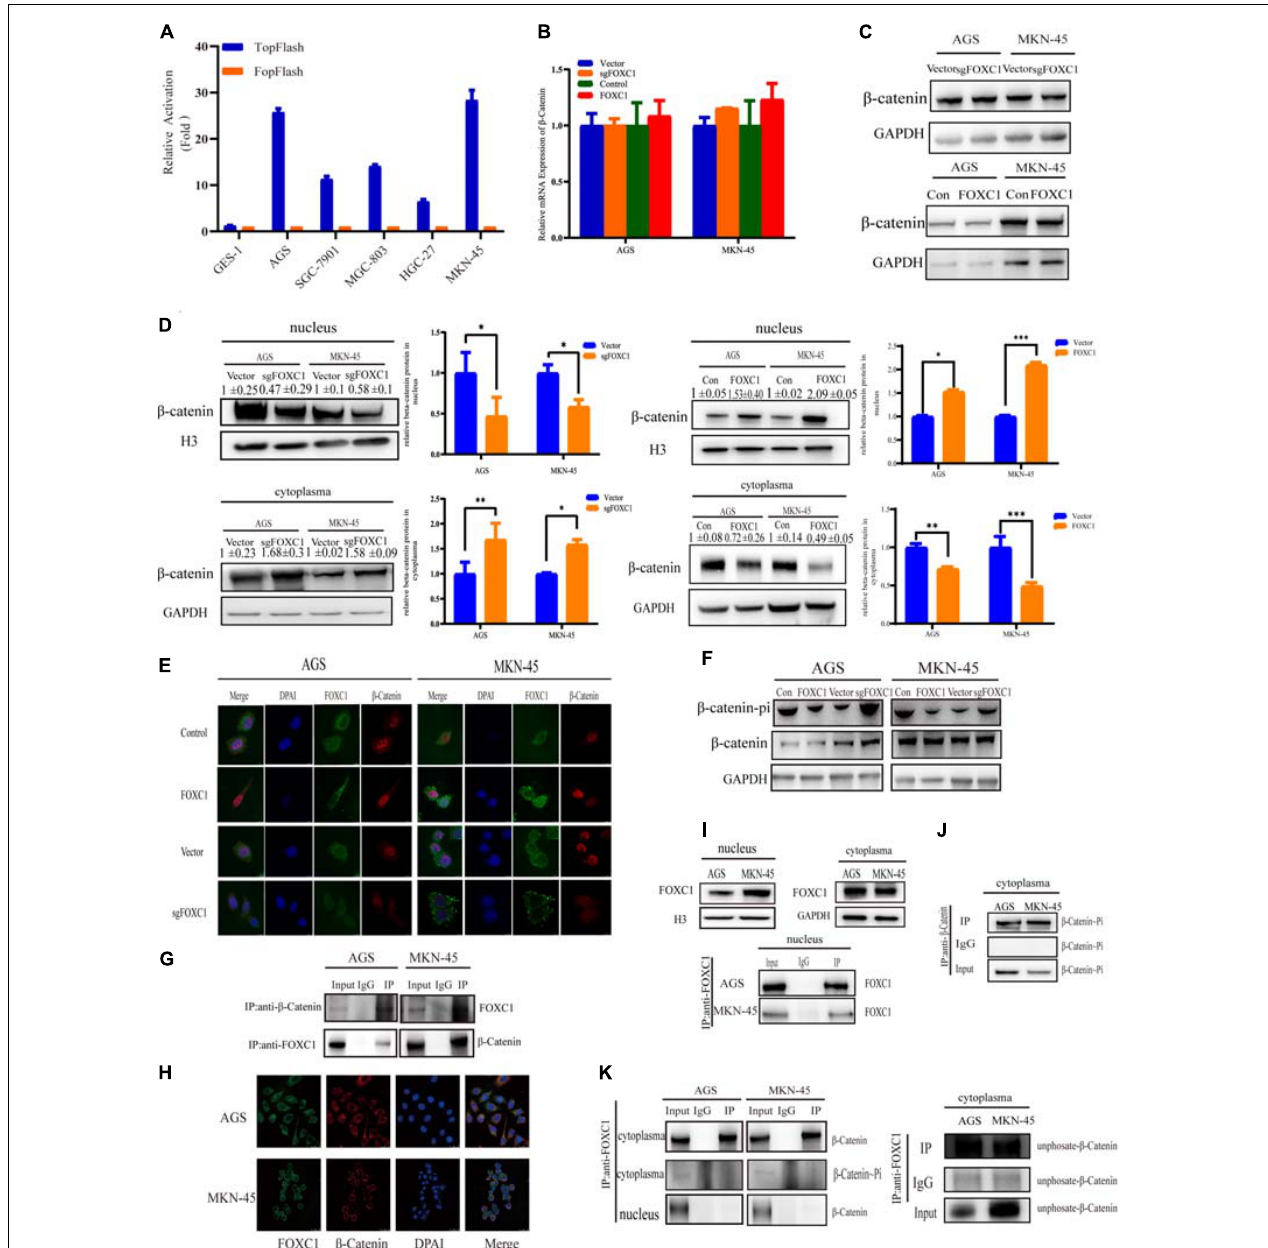
FIGURE 5 | FOXC1 enhances c-MYC expression to promote gastric cancer cell proliferation through activation of the Wnt signaling pathway. (A) TopFlash/FopFlash assays using normal gastric cells (GES-1) and gastric cancer cells (AGS, SGC-7901, MGC-803, MKN-45, HGC-27). (B) qPCR results in FOXC1 KO and FOXC1-overexpressing AGS and MKN-45 cells indicated that mRNA levels of β -catenin remained unchanged. (C) The results of western blot assays in FOXC1 KO and FOXC1-overexpressing AGS and MKN-45 cells indicated that protein levels of β -catenin remained unchanged ( β -catenin Antibody: CST #8480S). (D) FOXC1 KO increased β -catenin levels in the cytoplasm but decreased them in the nucleus ( β -catenin Antibody: CST #8480S). (E) Immunofluorescence assay in FOXC1 KO and FOXC1-overexpressing AGS and MKN-45 cells showed that the level of β -catenin translocation into nucleus changed with knockout and overexpression FOXC1 ( β -catenin Antibody: CST #8480S). (F) FOXC1 overexpression inhibit the phospho- β -Catenin (Ser33/37/Thr41) in AGS and MKN-45 cells (phospho- β -Catenin (Ser33/37/Thr41) Antibody: CST #9561T). (G,H) co-IP assays and immunofluorescence assay indicated that FOXC1 binds to the β -catenin protein in the cytoplasm ( β -catenin Antibody: CST #8084S; FOXC1 Antibody: Abcam #ab227977). (I) Western blot assays and immunoprecipitation assay were applied to confirmed the distribution of FOXC1 in the nucleus. (J) co-IP assay was applied to confirmed the distribution of phospho- β -Catenin (Ser33/37/Thr41) in the nucleus (phospho- β -Catenin (Ser33/37/Thr41) Antibody: CST #9561T). (K) co-IP assay was applied to confirmed whether FOXC1 bound to the β -catenin protein in the cytoplasm and nucleus. Immunoprecipitation assay results showed that FOXC1 bound to non-phospho- β -Catenin in the cytoplasm ( β -catenin Antibody: CST #8084S; phospho- β -Catenin (Ser33/37/Thr41) Antibody: CST #9561T; Non-phospho- β -Catenin (Ser33/37/Thr41) Antibody: CST #8814T), and FOXC1 did not bound to β -Catenin in the nucleus ( β -catenin Antibody: CST #8084S). * P < 0.05, ** P < 0.01, *** P < 0.001.